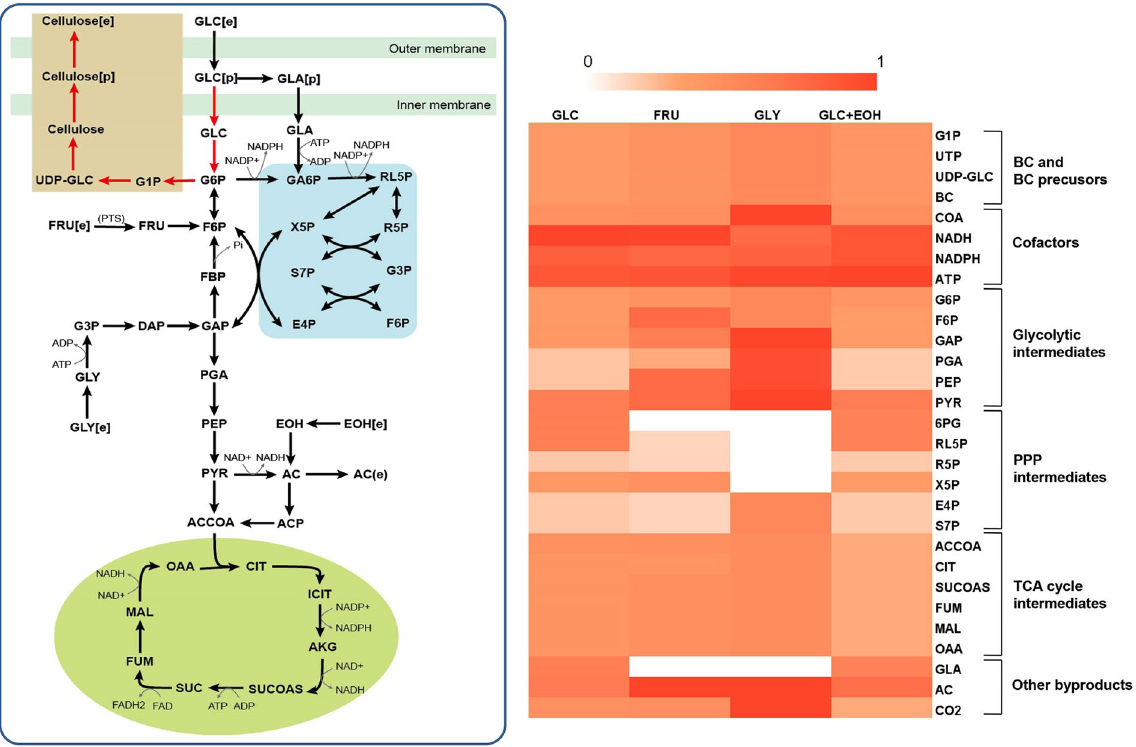
Figure 4. Flux-sum intensity comparisons for different carbon sources. A heatmap illustrating the flux-sum intensity of cofactors, by-products, and other components of central metabolism. The results were normalized to the maximal value of each metabolite, where the darker color indicates stronger